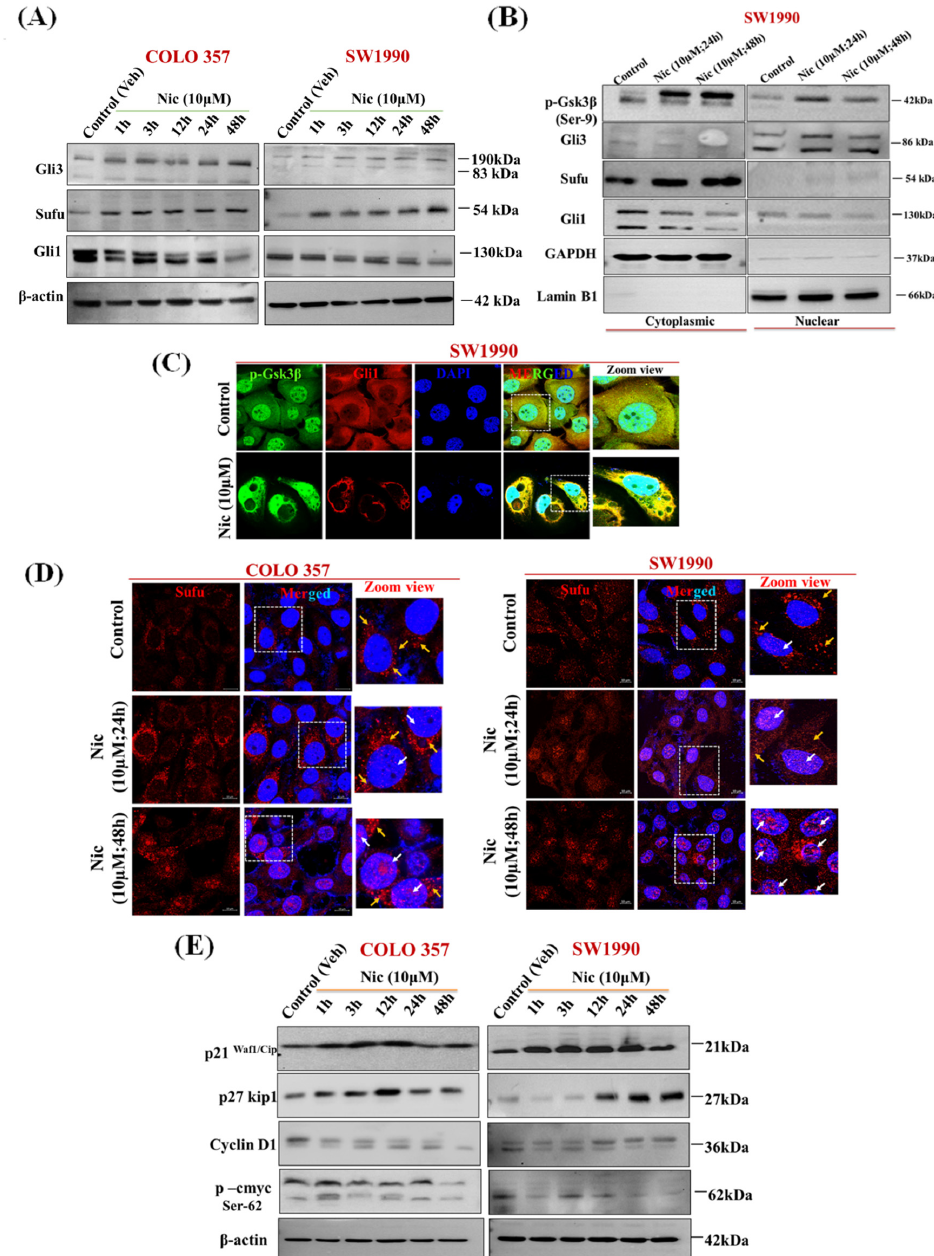
Figure 6. Nic inhibits Hh/Gli1 cascade via upregulation of Sufu and Gli3, a negative regulator of Hh signaling in PC cells ( A ) Representative Western blot images showing the expression of Hh signaling molecules such as Gli3 (transcription repressor), Sufu (a negative regulator of the pathway) and Gli1 (transcription activator) at different time points (1, 3, 12, 24, and 48 h) in COLO 357, Scheme 1990. cells treated with Nic (10 μ M). β -actin was used as an internal loading control. ( B ) Representative Western blots showing the expression of p-Gsk3 β , Sufu, Gli3, and Gli1 in cytosolic and nuclear extract of SW1990 cells treated with Nic (10 μ M; 24 and 48 h) as compared to control. GAPDH was used as purity control for cytosolic protein extraction, whereas, Lamin B1 was used as purity control for nuclear protein extraction. ( C ) Representative CLSM images showing the co-expression of p-Gsk3 β and Gli1 in SW1990 cells treated with Nic (10 µ M) for 24 h as compared to control. ( D ) Representative CLSM images showing nuclear translocation of Sufu in COLO 357, SW1990 cells treated with Nic for 24 and 48 h. ( E ) Representative Western blot images showing the expression of a downstream target molecule of Gsk3 β such as p21, p27, and cyclin D1 as well as Hh signaling downstream molecule like p-cMyc at different time points (1, 3, 12, 24, and 48 h) in COLO 357, SW1990 cells treated with Nic (10 µ M). β -actin was used as an internal loading